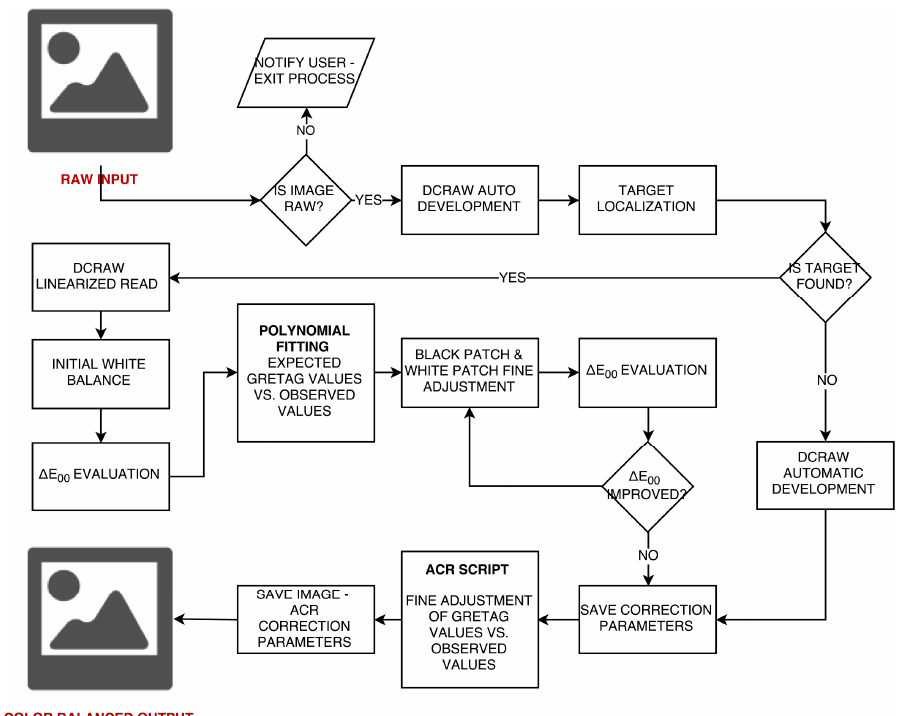
Figure 3. Radiometric calibration workflow presented in the article.